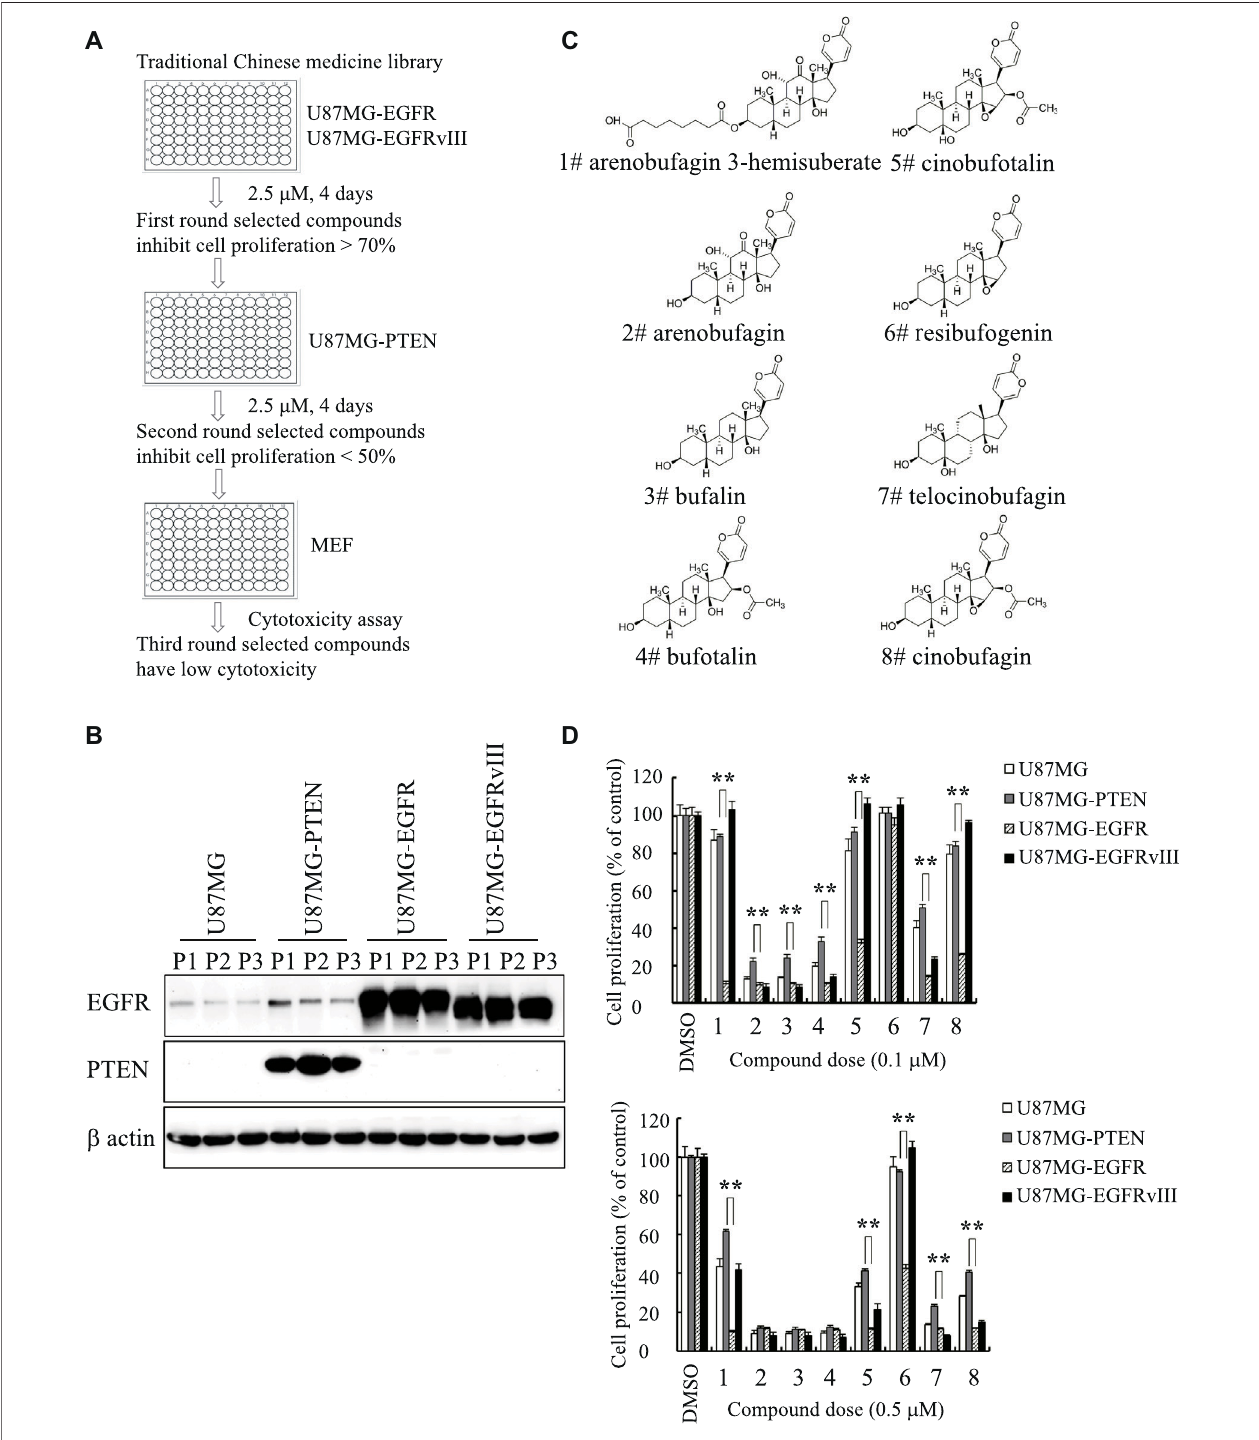
FIGURE1| Identi fi cationofcinobufaginanditsSARstudy. (A) Thediagramofdrugscreeningstrategy. (B) ExpressioncheckofEGFRandPTENinstablecelllines U87MG-control, U87MG-PTEN,U87MG-EGFR, and U87MG-EGFRvIII fromthe indicatedpassages. (C) Chemicalstructuresof8monomers ofChansu. (D) SARstudy ofChansu ’ smonomersfrom (C) andtheirantiproliferativeeffectsonU87MG-control,U87MG-PTEN,U87MG-EGFR,andU87MG-EGFRvIIIcells.1to8inhorizontalaxis represent the 8 compounds at panel (C) . Data are means ± SD.